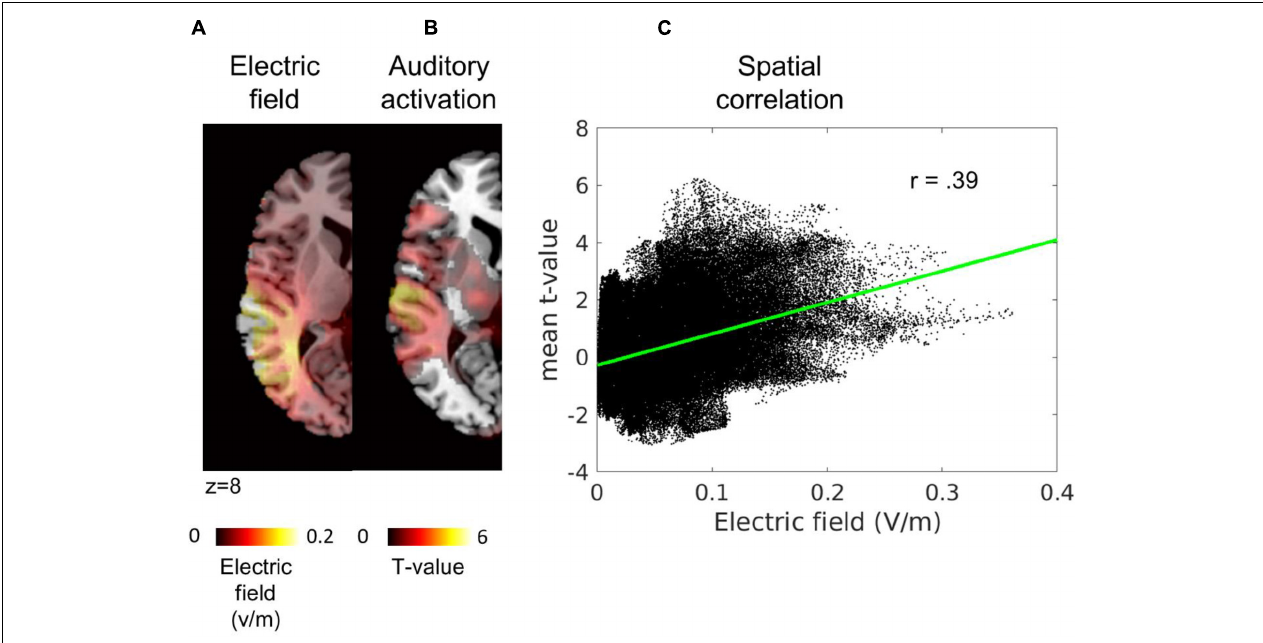
FIGURE 2 | Illustration TACS precision estimation. From left to right, (A) simulation of the electric field in a representative participant, (B) task evoked BOLD activity during sham stimulation in the same participant, and (C) the spatial correlation between the two variables. Each black dot in the scatter represents one voxel: x -axis = the simulated electric field value, y -axis = mean t -value from the contrast auditory > baseline. In red, the least-square line of the correlation. Thresholded maps were used for visualization purposes in panels (A,B) . As can be seen in panel (C) , the whole map was used to compute the spatial